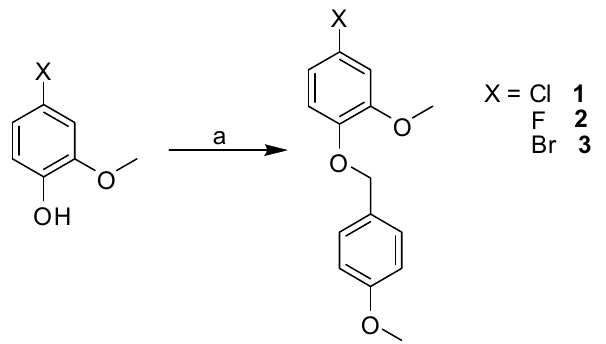
Scheme 1. Synthesis of benzylphenylether derivatives. Reagents and conditions : ( a ) PMBCl, NaH, DMF, 0 °C to r.t., 4–6 h, X = Cl (29%), F (47%), Br (23%).